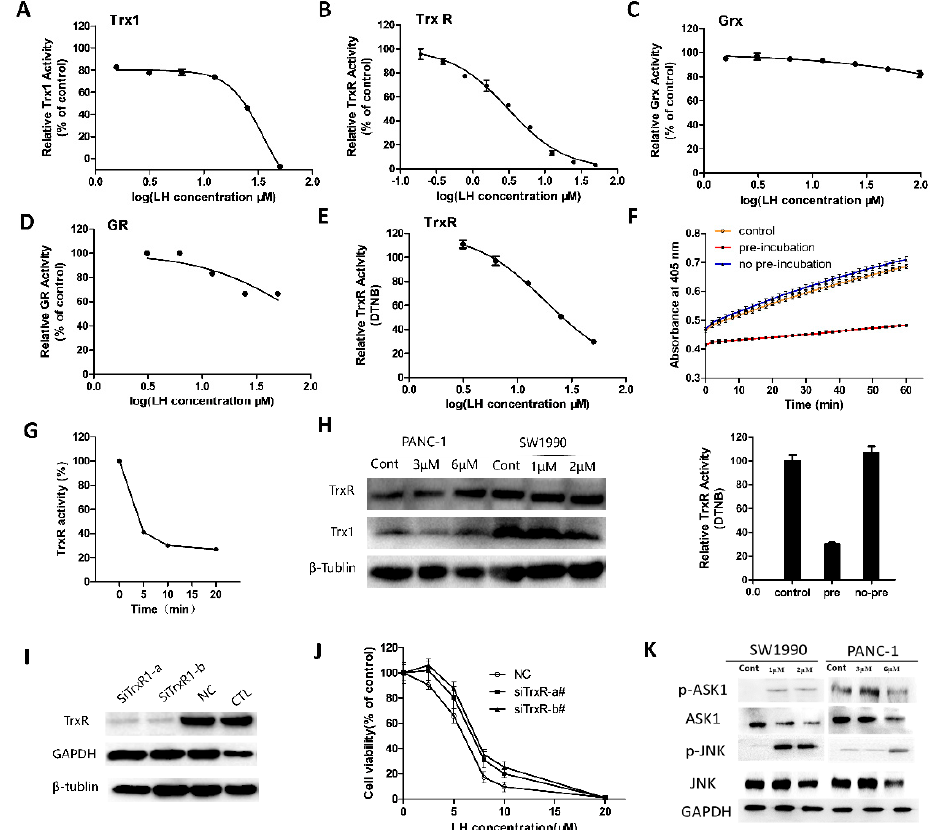
Figure 3. LH exhibited effective inhibition on Trx/ TrxR system. In vitro assays for Trx1 ( A ), TrxR ( B ), Grx1 ( C ), GR ( D ). For Trx1 activity assay, 0.04 µ M Trx1, 1 µ M TrxR was incubated with LH. For TrxR activity assay, 0.4 nM of TrxR, 2 µ M TrxR was incubated with LH. For Grx activity assay, 0.6 nM of hGrx-1, 50 nM GR, 0.5 mM GSH was incubated with LH. For GR activity assay, 20 µ M of GR, 1 mM GSH was incubated with LH. ( E ), TrxR was pre-reduced with NADPH for 30 min with indicated concentrations of LH, followed by addition of DTNB. ( F ), 50 µ M LH was pre-incubated or no pre-incubated with TrxR for 30 min, followed by addition of DTNB. ( G ), NADPH-reduced TrxR was incubated with 10 µ M LH for 0, 5, 10, 20 min. ( H ), Expression levels of Trx1 and TrxR1 in SW1990 and PANC-1 cells were determined after incubating with indicated concentration of LH for 24 h by Western blotting. β -tublin served as protein-loading control. ( I ), Knockdown efficiency was analyzed after SW1990 cells transfected with TrxR siRNA, control siRNA and positive GAPDH siRNA for 48 h by Western blotting. ( J ), TrxR-silenced SW1990 cells and control cells were treated with 0, 2.5, 5, 8, 10, 20 µ M LH for 48 h, and cell viability was measured by CCK8 assay. ( K ), SW1990 and PANC-1 cells were incubated with indicated concentration LH for 48 h. Total and activation forms of ASK1 and JNK were evaluated by Western blotting. GAPDH is shown as a protein-loading